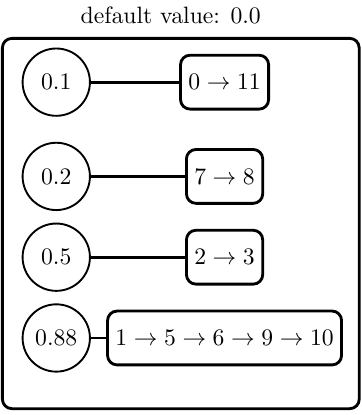
Figure 12. Approximation of φ obtained in the second iteration.